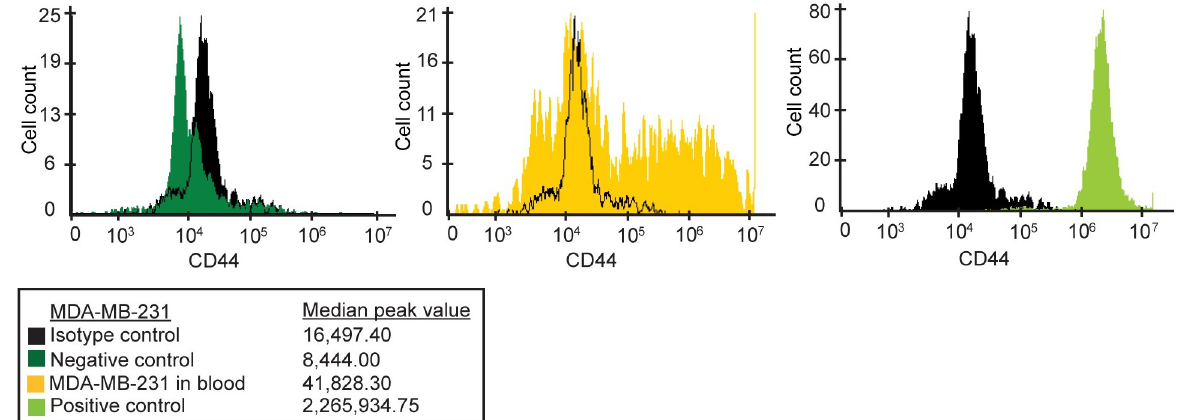
Fig 5. Recovered breast cancer cells that have dim CK and are CCT2 positive, also express CD44. MDA-MB-231 cells recovered from the spike in blood were stained and measured for CD44 levels in gated CCT2 positive cells. Alexa-405 served as the isotype control (black). The left panel shows the negative control which was healthy blood cells only stained for CD44 (dark green). The middle panel shows the CCT2 positive spiked cancer cells stained for CD44 (yellow). The right panel shows the positive control which was MDA-MB-231 cells (not spiked in blood) stained for CD44 (light